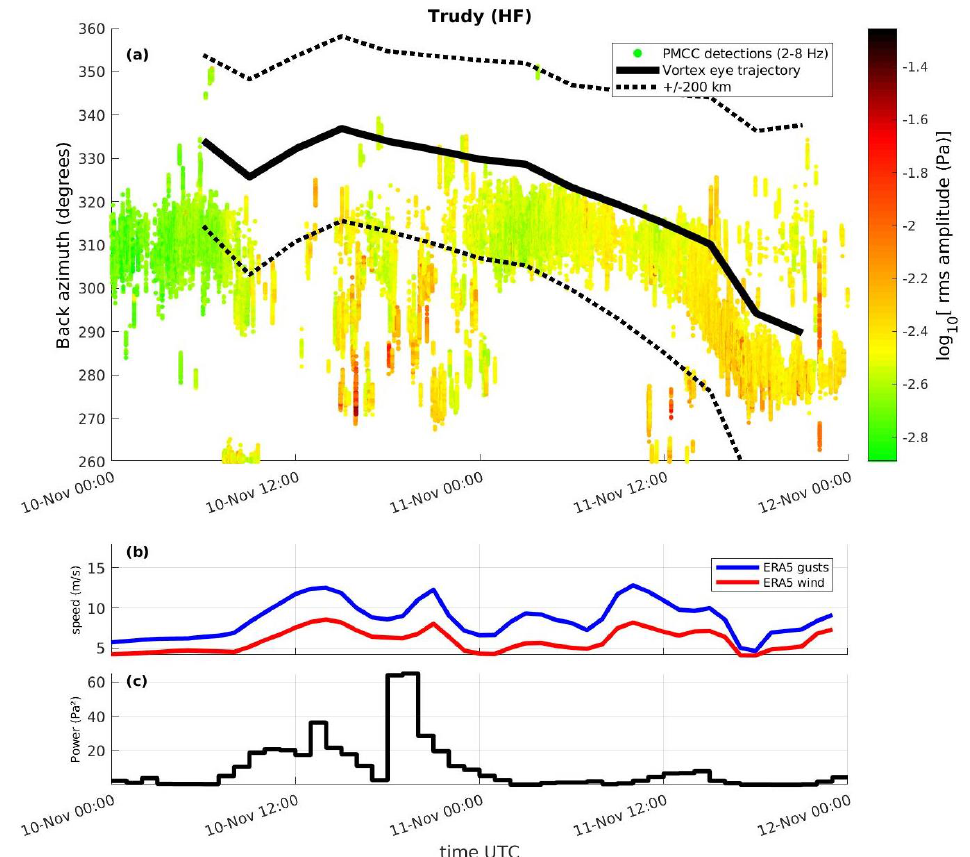
Figure 3. Time series ( a ) of the detection azimuths obtained with PMCC processing in the higher frequency (HF) range (28 Hz) applied to IS48 data when Medicane Trudy was active, ( b ) of the wind fields at the surface obtained from ERA5 (blue for wind gust and red for wind), and ( c ) of a proxy indicative of wind noise (see text for detail). In the top plot, the colors code for the rms amplitude of the signal on a logarithmic scale (log10). The dotted lines indicate a +/ − 200 km distance to the vortex center in order to guide the eye.